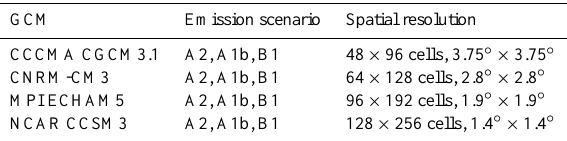
Table 3. GCMs downscaled for this